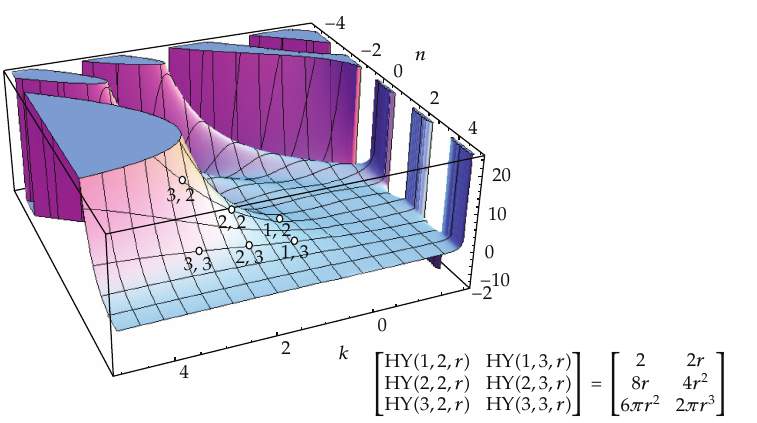
Figure 2: The surface graphic of the hypercylindrical function with the constant radius r (cid:7) 1 and the selected fields of freedom degrees (cid:2) − 4 < n ≤ 5 (cid:3) and (cid:2) − 2 < k ≤ 5 (cid:3) (cid:2) using the software Mathematica (cid:3)